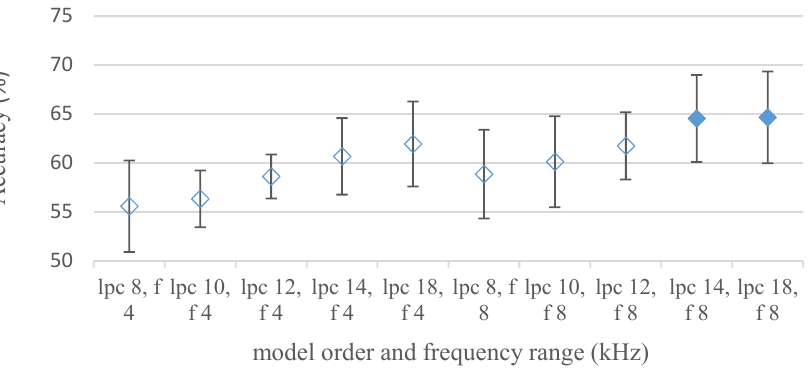
Figure 13. Averaged accuracies and standard deviations for linear prediction coefficient (LPC) model orders (lpc) ranging from 8 to 18, for 4 and 8 kHz maximal frequencies (f), and no pre-em- phasis. Filled marks show equally performing settings.